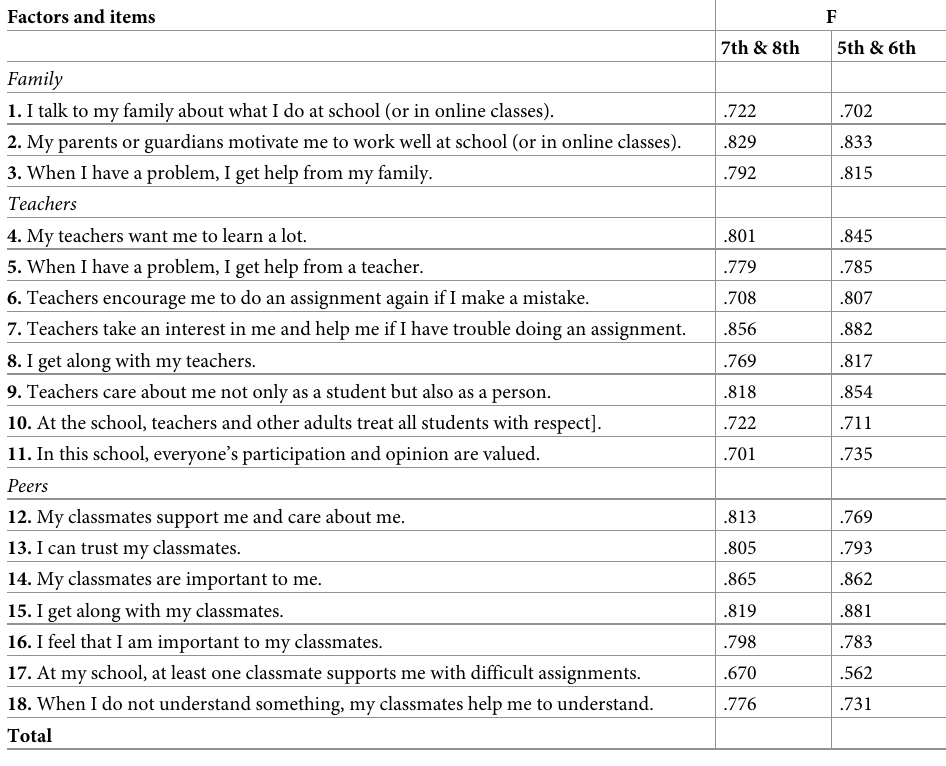
Table 2. Items content and factor loadings of the contextual factors questionnaire. Factors and